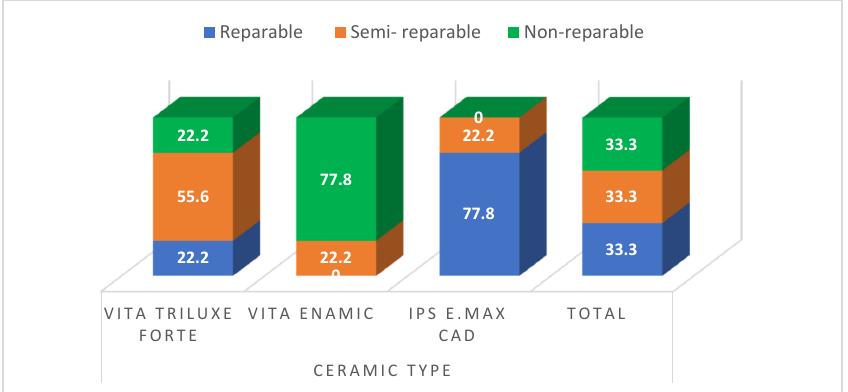
Figure 6. Fracture type percentage among different ceramic materials.